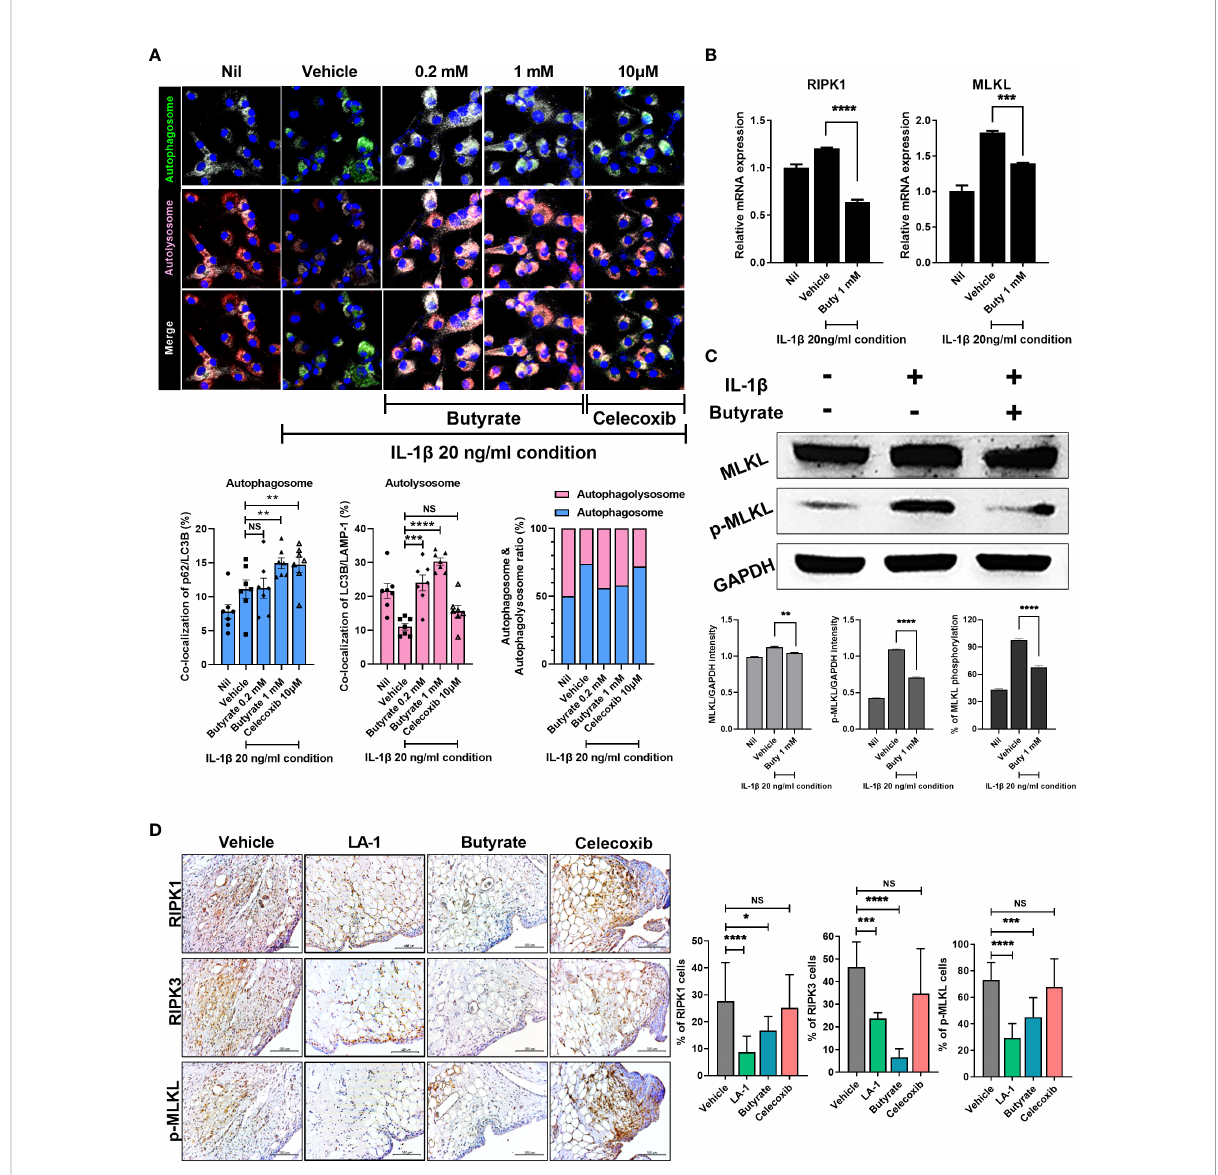
FIGURE 7 Butyrate reduced in fl ammatory cell death by restoring abnormal autophagy of chondrocytes in an in fl ammatory environment. (A) Effect on autophagy of butyrate in chondrocytes cultured in medium with IL-1 b at 20 ng/ml (magni fi cation ×200). (B) Effect of butyrate on the expression levels of necrosis factors of chondrocytes under in fl ammatory conditions. (C) In chondrocytes, the effect of butyrate on MLKL phosphorylation in chondrocytes under in fl ammatory conditions. (D) IHC showed that live LA-1 and butyrate modulated the levels of necroptosis factors in OA synovial tissue (magni fi cation ×400). Data are means ± SD (* p < 0.05, ** p < 0.01, *** p < 0.005, **** p < 0.001), ns, not signi fi